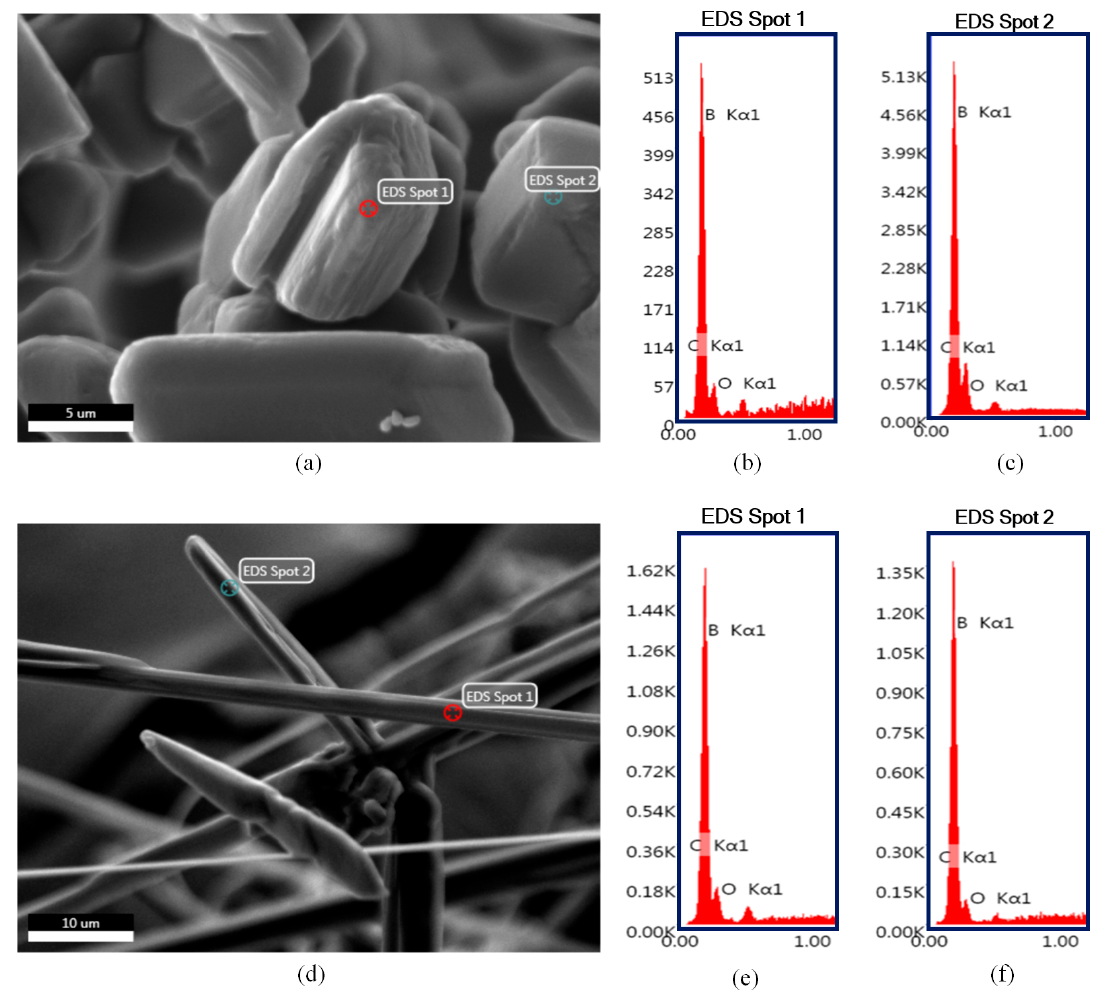
Figure 5. SEM-EDS point analysis results of the boron carbide as-synthesized powders derived from ( a – c ) 1Y and ( d – f ) 2Y precursors.